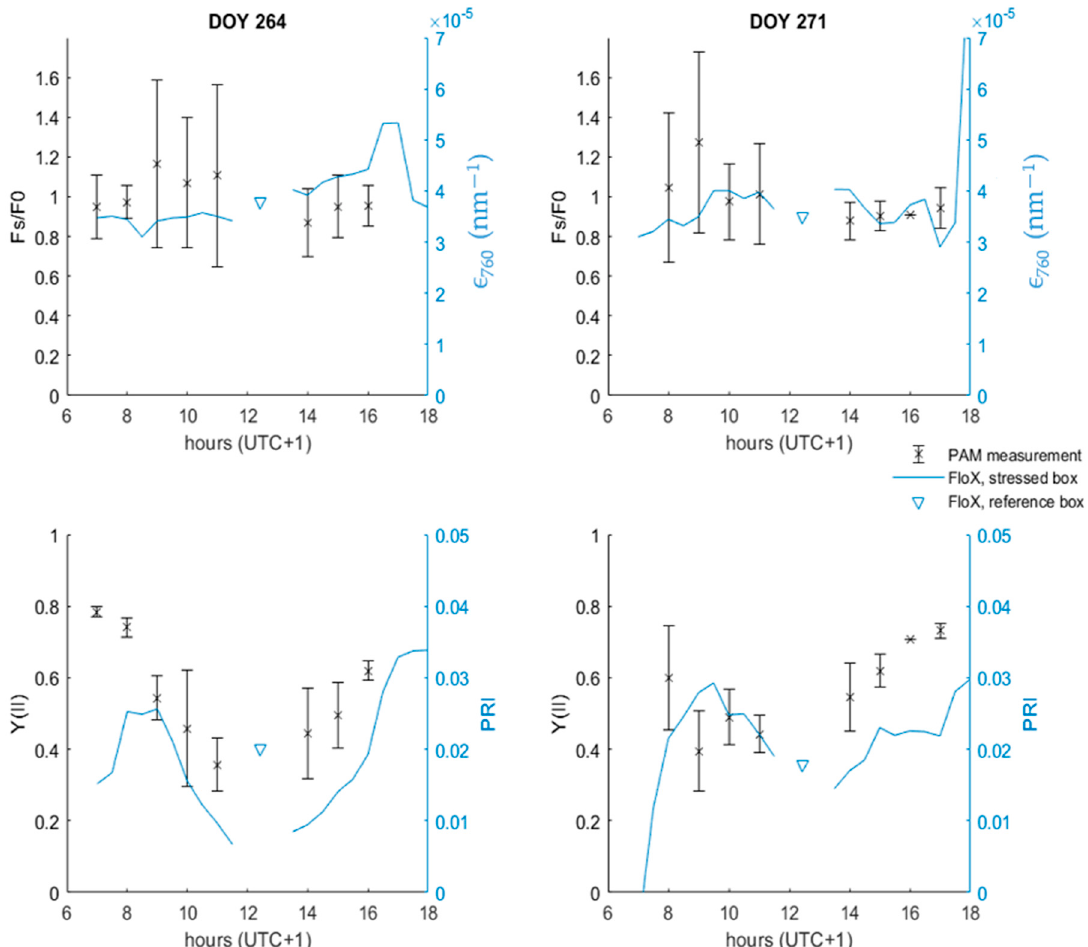
Figure 9. Behaviour of the PAM-based variables Fs/F0 and Y(II) as well as two FloX-based variables, ϵ 760 and PRI for DOY 264 and DOY 271 during the lettuce experiment. Each PAM data point is an average of 10 measurements. The PAM measurements were taken in the stressed box.